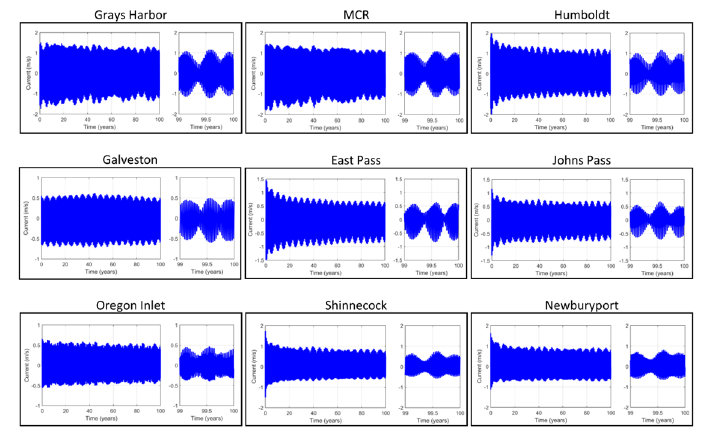
Figure 10. Time series of along ‐ channel currents in the inlet throat.